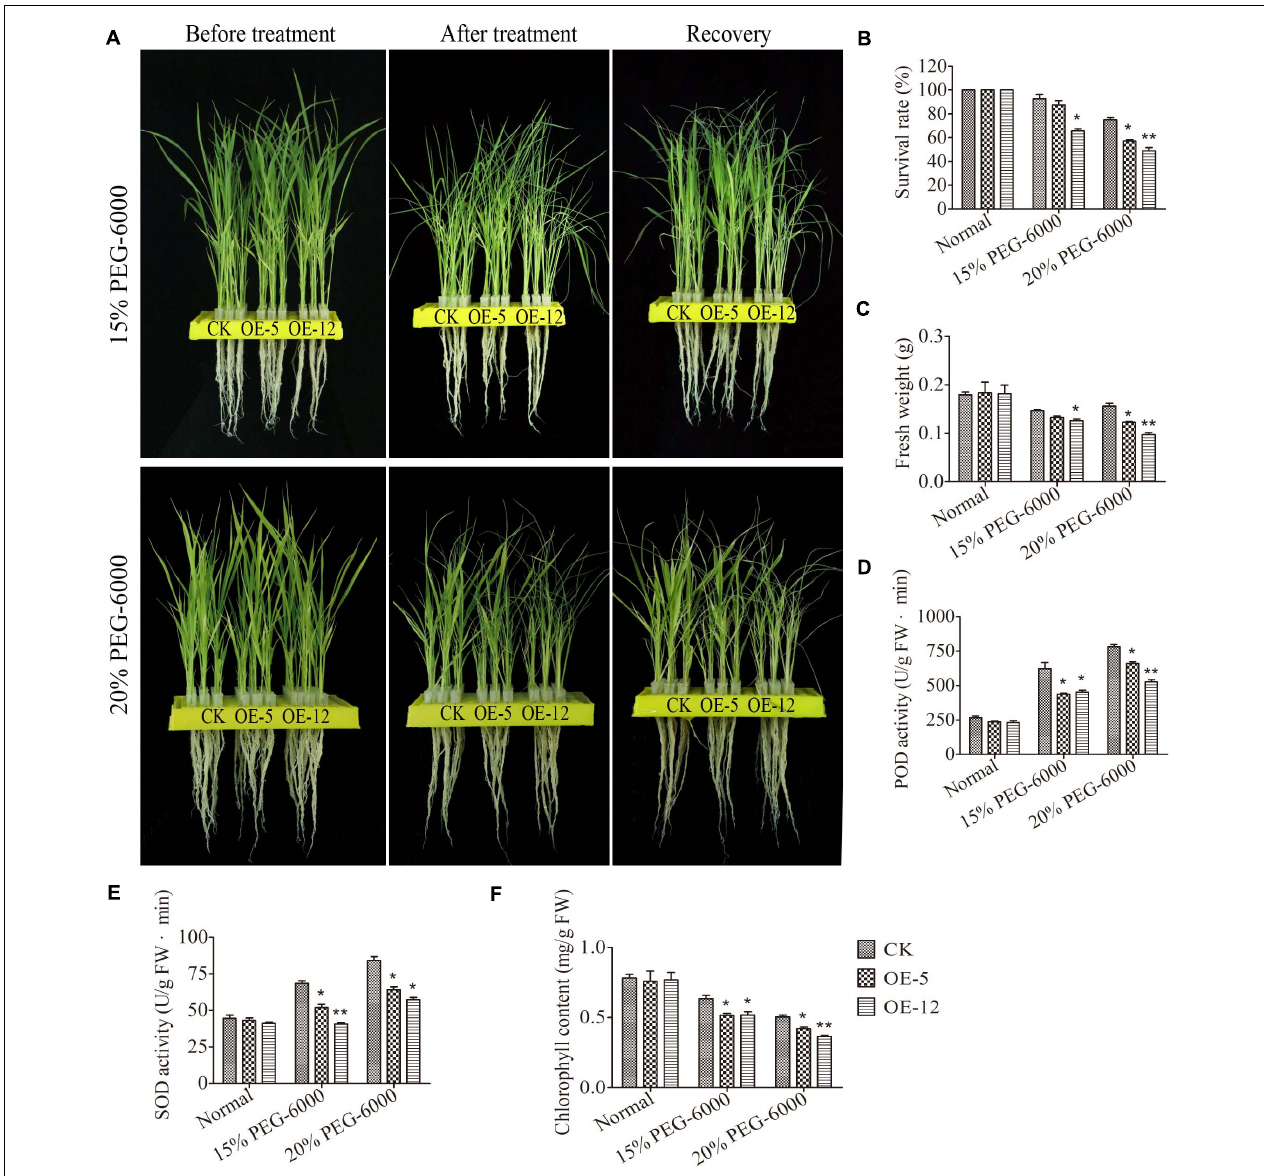
FIGURE 9 | Overexpression of SiMADS51 reduces tolerance to drought stress in transgenic rice plants. (A) Phenotypes of CK and SiMADS51 -transgenic rice under the treatment of PEG-6000. (B) Survival rate and (C) fresh weight of normal and PEG-6000 stressed plants. (D) POD, and (E) SOD activities were measured under PEG-6000 stress and normal growth conditions. (F) Chlorophyll content were detected in CK and OE plants under PEG-6000 stress or normal growth condition. Data are presented as the means ± SDs of three independent replicates. The asterisks indicate significant differences between WT and SiMADS51 -overexpressing lines (* P < 0.05; ** P < 0.01; Student’s t